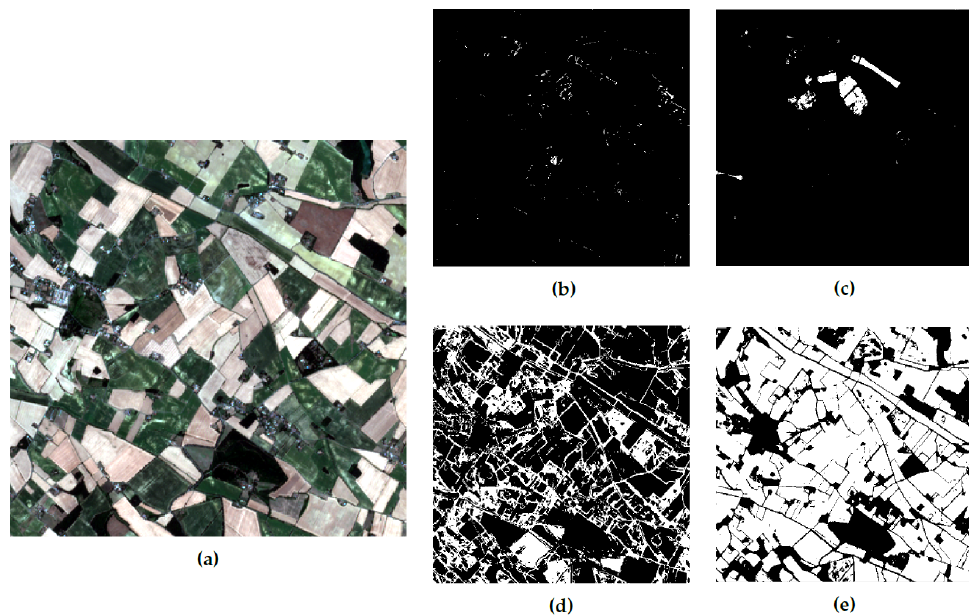
Figure 8. A first visual evaluation zone with ( a ) its RGB composite and the corresponding binary classification maps for ( b ) RF PUL , ( c ) ENSEMBLE PUL , ( d ) OCSVM, and ( e ) PUL-SITS for the positive class Cereals/Oilseeds with the number of positive training data objects ( n ) equal to